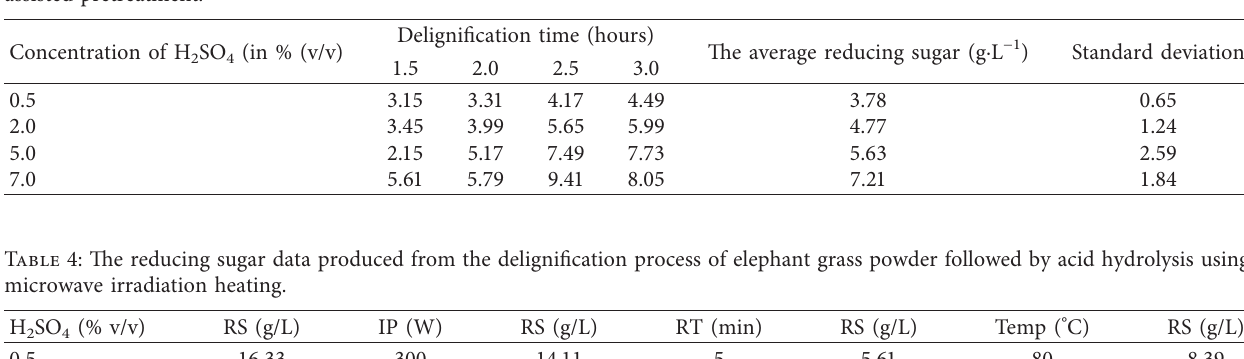
Table 3: The effect of delignification time and H 2 SO 4 concentration on the average glucose concentration produced without microwave- assisted pretreatment.